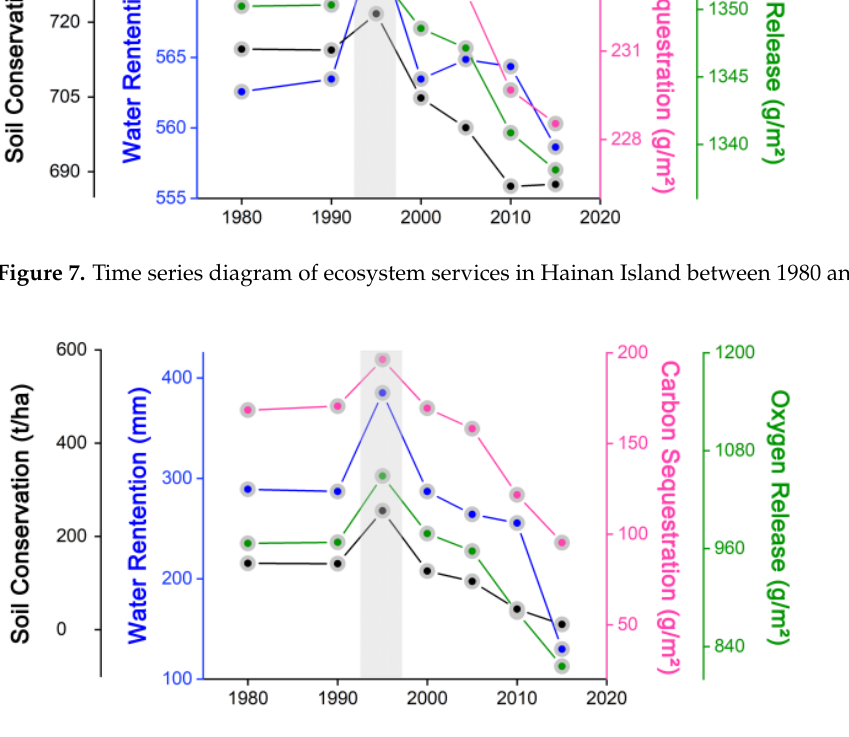
Figure 8. Time series diagram of ecosystem services in urban areas in Hainan Island between 1980 and 2015.